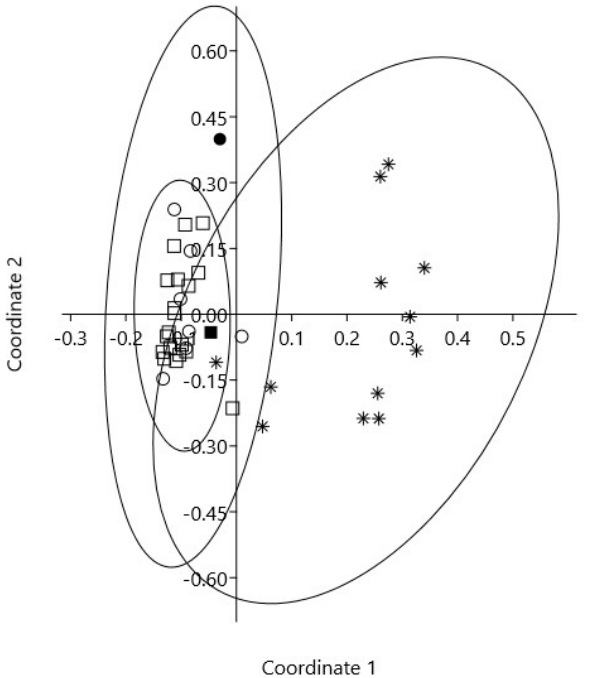
Figure 2. Scatterplot of the first and second axes of principal coordinate analysis (PCoA) of essential oils of J. oxycedrus (squares), J. macrocarpa (circles), and J. deltoides (asterisk). Filled symbols represent our samples. Species’ 95% concentration ellipses are superimposed.